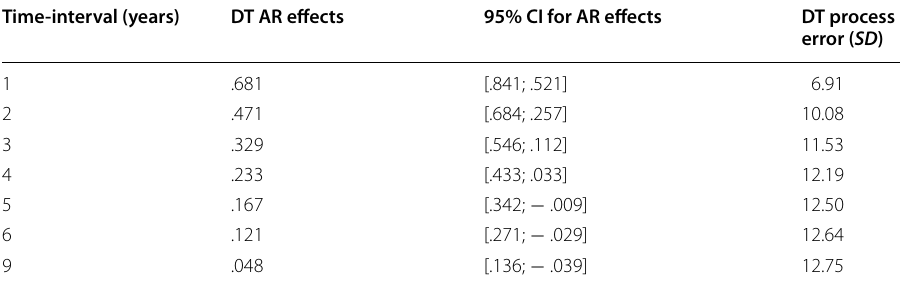
Table 4 Discrete-time parameters for autoregression (AR) and process error for varying time- intervals derived from underlying continuous-time parameters Time‑interval